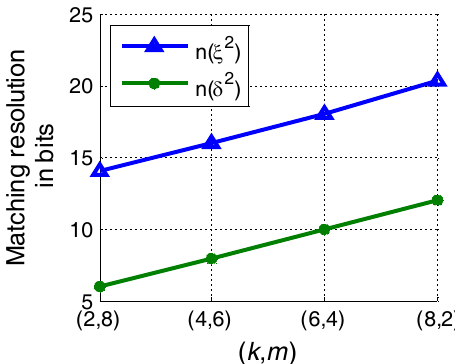
Figure 7. The matching resolution in bits for the different combinations of k and m for n = k + m = 10 by assuming that each component contributes equally to the nonlinearity.